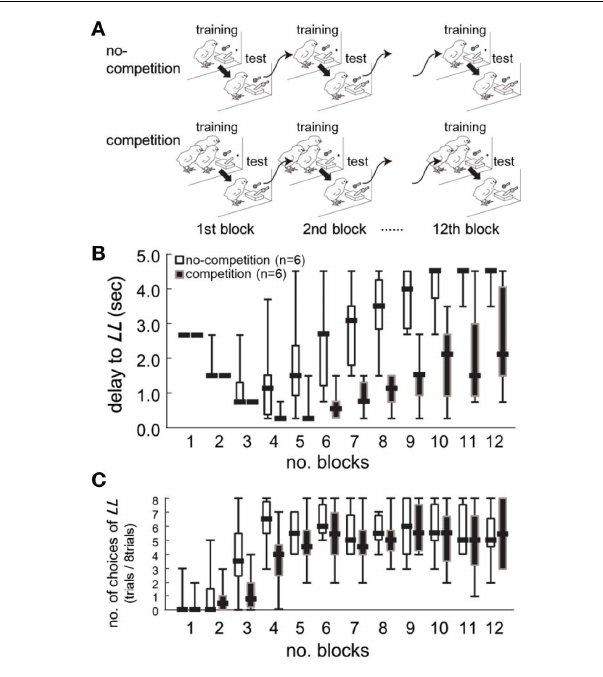
FIGURE 2 | Competition caused lasting and cumulative effects on impulsiveness. Data obtained from the two groups of chicks ( n = 6 each) are shown. (A) Experimental procedure of the behavioral titration. By adjusting the delay to the large–long delay reward [ LL , (B) ], we searched for an equilibrium point at which both options were equally chosen (C) . Chicks were trained and tested for 12 days (1 block per day) from post-hatch day 7. In the no-competition group (upper), chicks were trained in isolation. In the competition group (lower), chicks were trained in a group of three chicks. Note that chicks were tested in isolation in both groups. (B) Delay to LL was plotted against the number of blocks. Short horizontal bars indicate the median, boxes the 25–75% range, and whiskers the min–max range, respectively. (C) The number of choices of LL was similarly